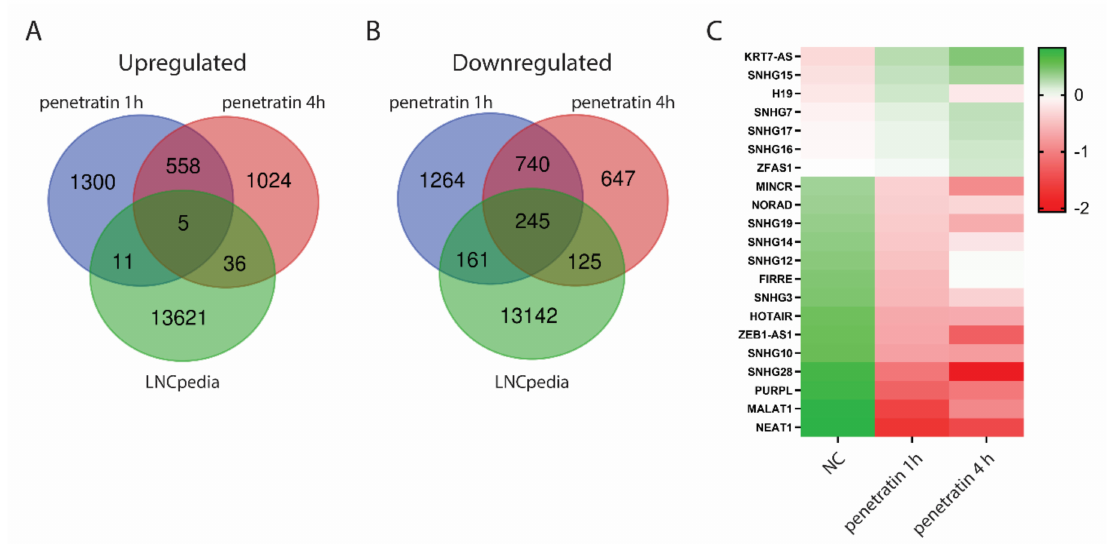
Figure 9. ( A , B ) Venn diagrams showing intersection between up- or down-regulated genes upon 1- or 4-h treatment with penetratin and the LNCpedia database of long non-coding RNAs. ( C ) Heatmap of selected LncRNAs found in the analysis. Genes are organized in descending order based on the averaged log2(normalized read counts) for each